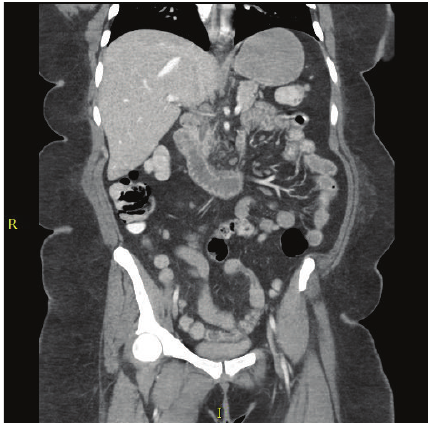
Figure 1: Showing Pneumatosis Intestinalis in right lower quadrant in a coronal cut of CT imaging.